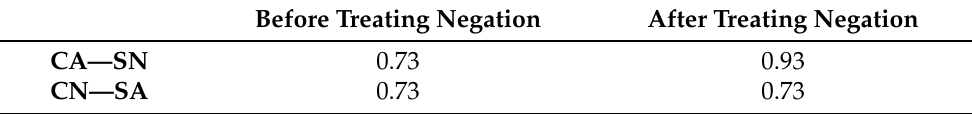
Table 3. Effect of negation on classification F